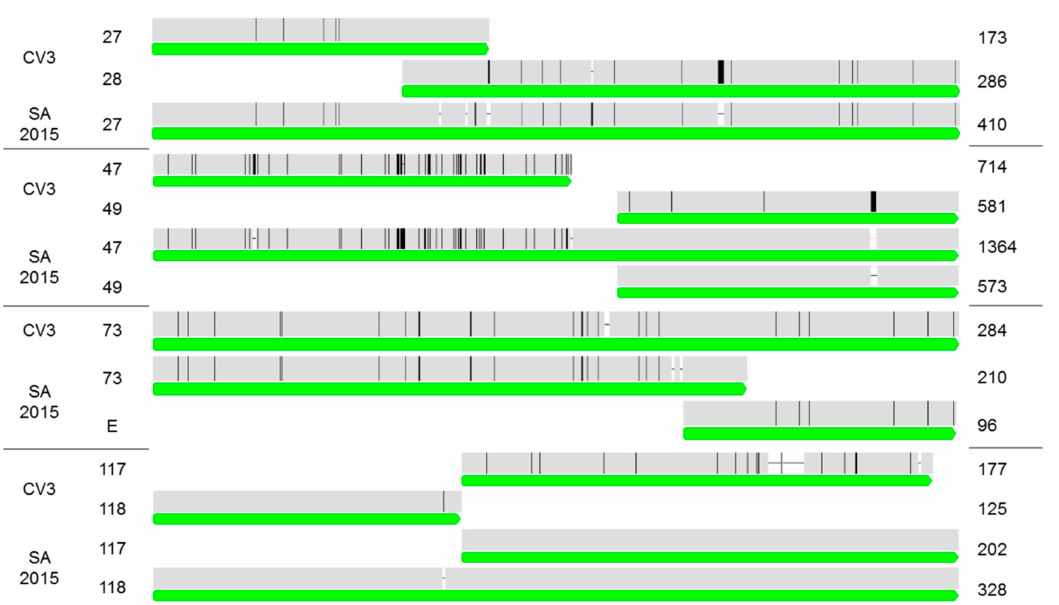
Figure 2. Nucleotide alignments of fusion events in CrleGV-CV3 and CrleGV-SA (2015) for ORFs 27/28, 47/49, 73/E, and 117/118. Green bars show gene annotations, with the graphs highlighting disagreements as black bars in each alignment to the consensus sequence. Gaps in each alignment are shown as white spaces in the graphs, with the amino acid length of each ORF shown to the right.